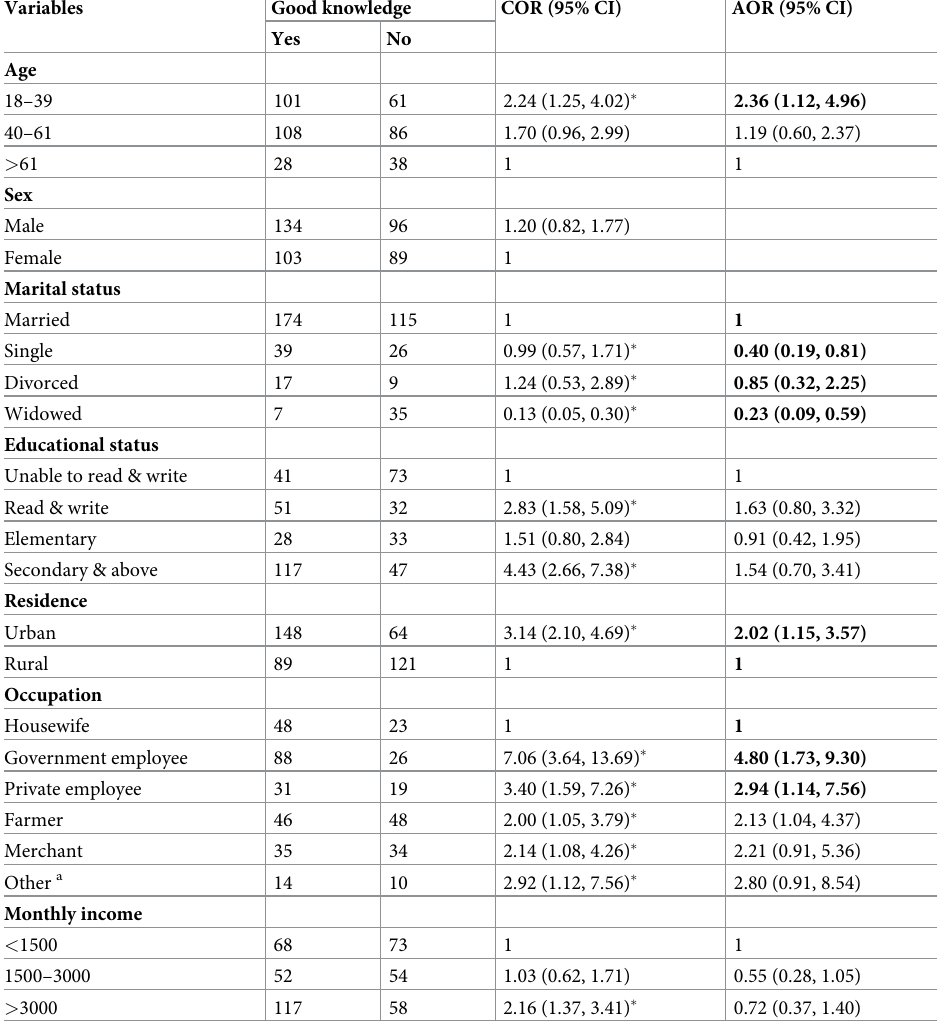
Table 4. Factors associated with good knowledge of COVID-19 among chronic disease patients, at selected public hospitals of Sidama regional state, Ethiopia, 2020 (N = 422).